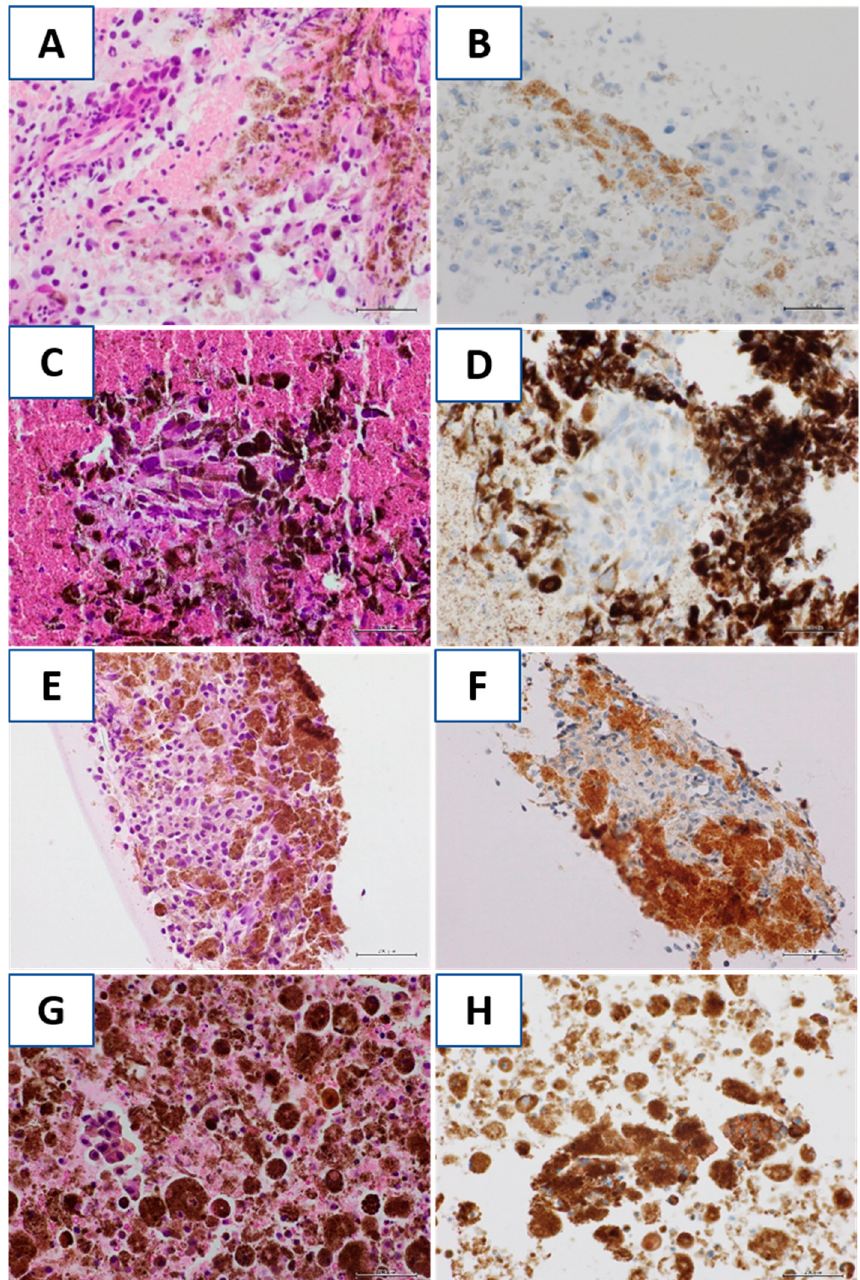
Figure 4. ( A , B ) Case 1, presence of melanic pigment in the cytoplasm of histiocytes and melanoma cells on cell-block section. BRAF ICC was negative in malignant cells. In this case, at the molecular assessment, BRAF resulted from wild-type; ( C , D ) Case 2, a melanoma cellular group in a proteinaceous background with melanic pigment on cell-block section. BRAF ICC was negative in the malignant group. At the molecular assessment, BRAF was wild-type; ( E , F ) Case 3, a cellular aggregate of melanoma cells in a melanic background on cell-block section. BRAF ICC was negative in the neoplastic cells. At the molecular assessment, BRAF V600R mutation was detected; ( G , H ) Case 4, numerous engulfing histiocytes melanic pigment, which is also present in the background and few melanoma cells were present on cell-block section. BRAF ICC was considered not evaluable. At the molecular assessment, a BRAFV600E was detected. (Hematoxylin-eosin and immunocytochemical stains, original magnification 400×).